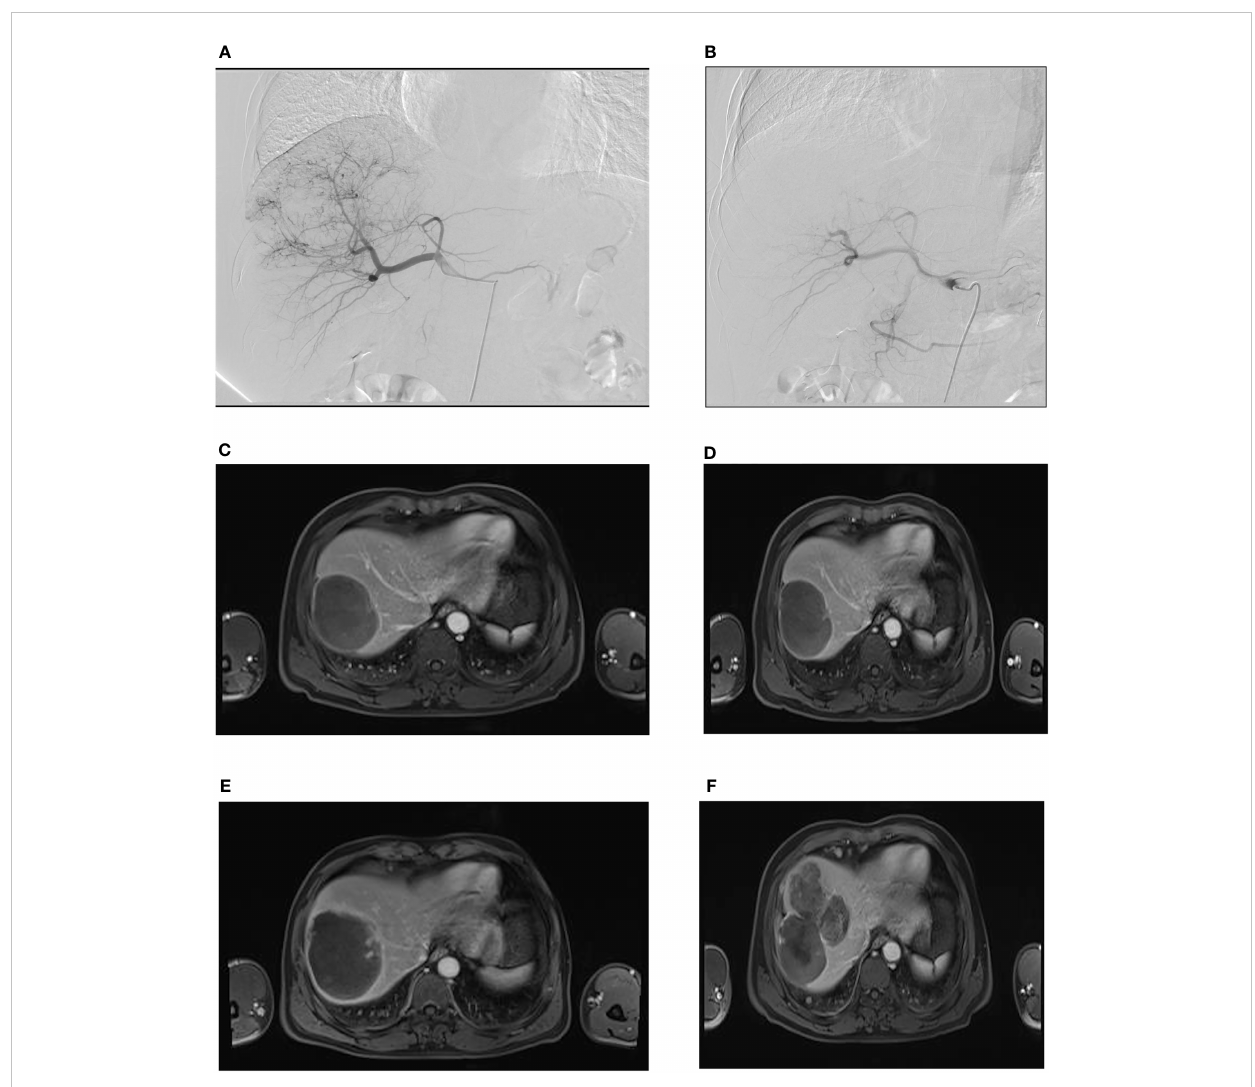
FIGURE 3 Rough-type tumor margins observed on an axial MR image. A male patient, aged 55 years, was admitted to our hospital with a complaint of right upper abdominal pain for 3 days. (A) During the fi rst administration of DEB-TACE, hepatic arteriography showed massive abnormal hyperchromatism in the right posterior lobe of the liver. (B) Abnormal hyperchromatism disappeared at the end of the arterial phase, as observed through contrast reexamination after DEB-TACE; (C) the patient was included in the follow-up after the second administration of DEB-TACE, and MR images showed a rough-type margin on the left side of the tumor (black arrow). (D) One month after the start of the follow-up period, the rough-type margin (black arrow) was slightly larger than that in (C) . (E) Three months after the start of the follow-up, the thickness of the rough-type margin (black arrow)